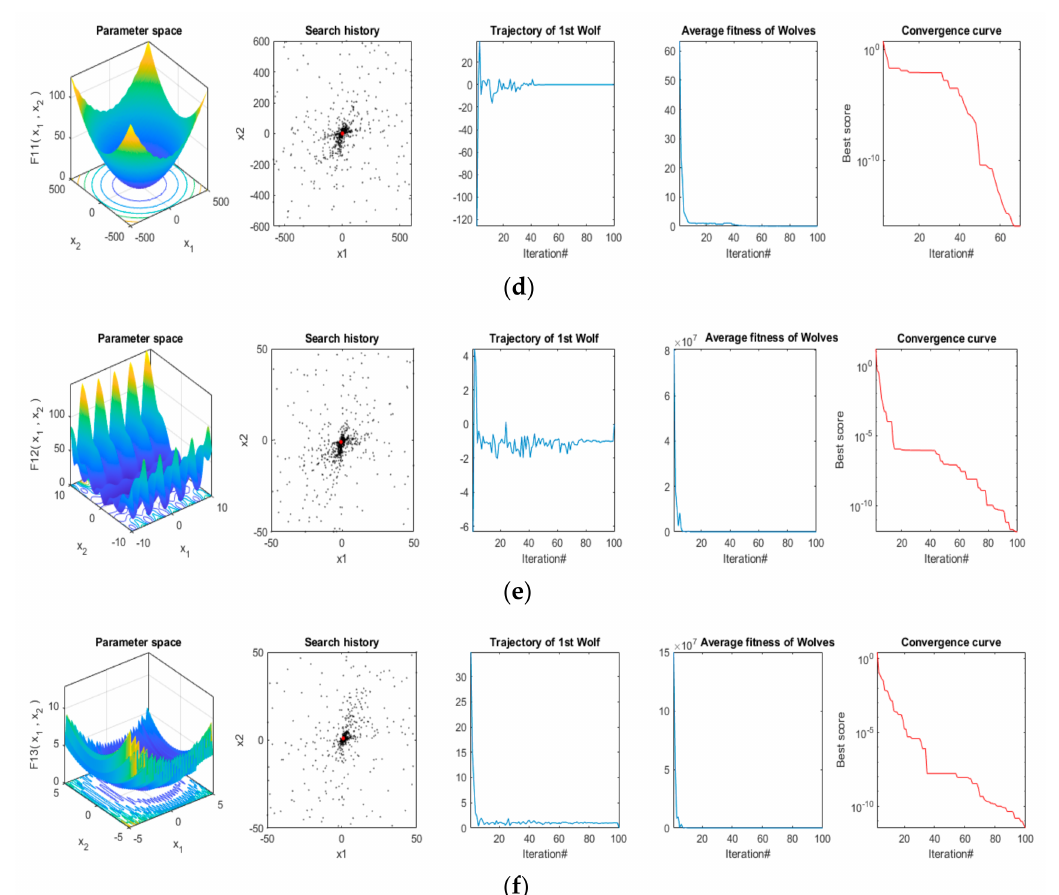
Figure 5. Parameter space, search history, trajectory of 1st wolf, the average fitness of wolves, and convergence curve of NGWO for multi-modal functions (F 8 –F 13 ). Here, ( a ) represents benchmark function F 8 , ( b ) represents benchmark function F 9 , ( c ) represents benchmark function F 10 , ( d ) represents benchmark function F 11 , ( e ) represents benchmark function F 12 , ( f ) represents benchmark function F 13